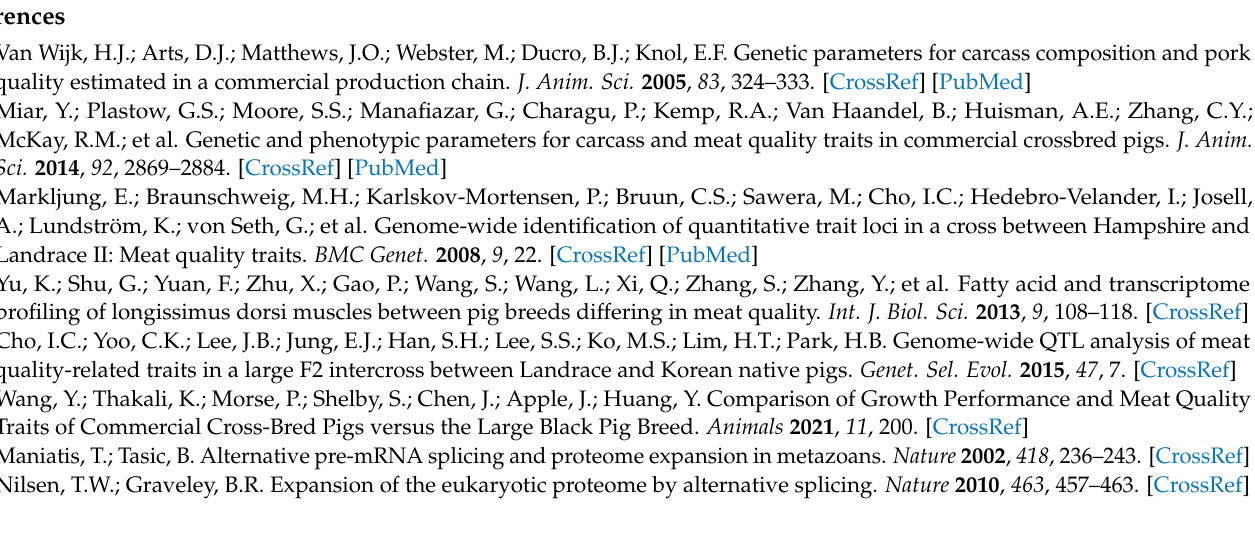
seq. Table S2-a. All transcripts identified by Iso-seq. Table S2-b. Novel gene loci identified by Iso-seq. Table S2-c. Novel protein-coding genes identified by Iso-seq. Table S2-d. Novel lncRNA identified by Iso-seq. Table S2-e. Fusion transcripts identified by Iso-seq. Table S3. Differential alternative splicing events. Table S4. Characterization of DAS genes. Table S4-a. DAS genes in semitendinosus compared to longissimus thoracis muscle. Table S4-b. Total genes identified in semitendinosus and longissimus thoracis muscles. Table S4-c. GO classification of DAS genes. Table S4-d. KEGG classification of DAS genes. Table S5. Identification of DE-DAS genes. Table S5-a. DEGs in semitendinosus compared to longissimus thoracis muscle. Table S5-b. DE-DAS genes in semitendinosus compared to longissimus thoracis muscle. Table S5-c. GO classification of DE-DAS genes. Table S5-d. Differentially expressed TFs in semitendinosus compared to longissimus thoracis